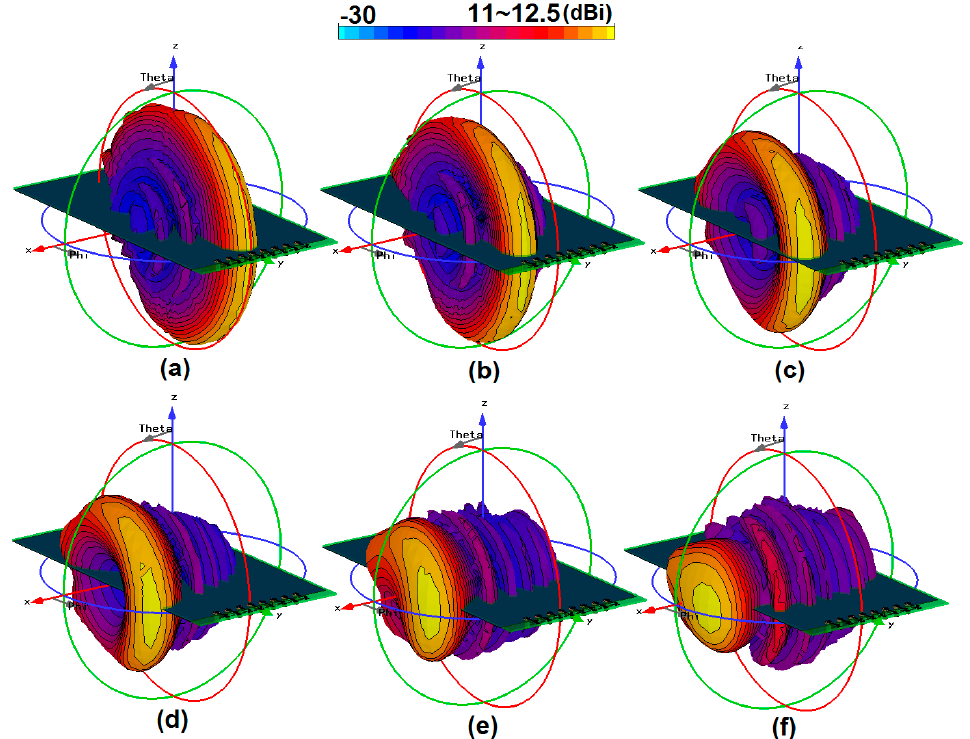
Figure 15. 3D radiation beams of the 5G smartphone design at ( a ) 0 ◦ , ( b ) 15 ◦ , ( c ) 30 ◦ , ( d ) 45 ◦ , ( e ) 60 ◦ , and ( f ) 75 ◦ .